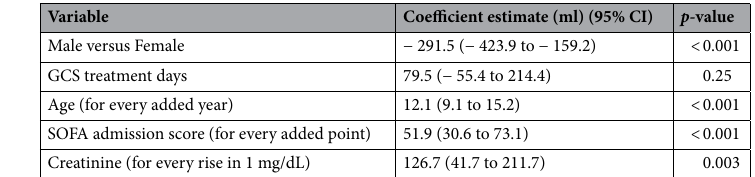
Table 2. Model 1 of the estimated effect of glucocorticoids (GCS) treatment per day on daily fluid balance (ml) in patients with sepsis in the intensive care unit (ICU). In this model, all the days with GCS were compared to all the days without GCS. SOFA sequential organ failure assessment.